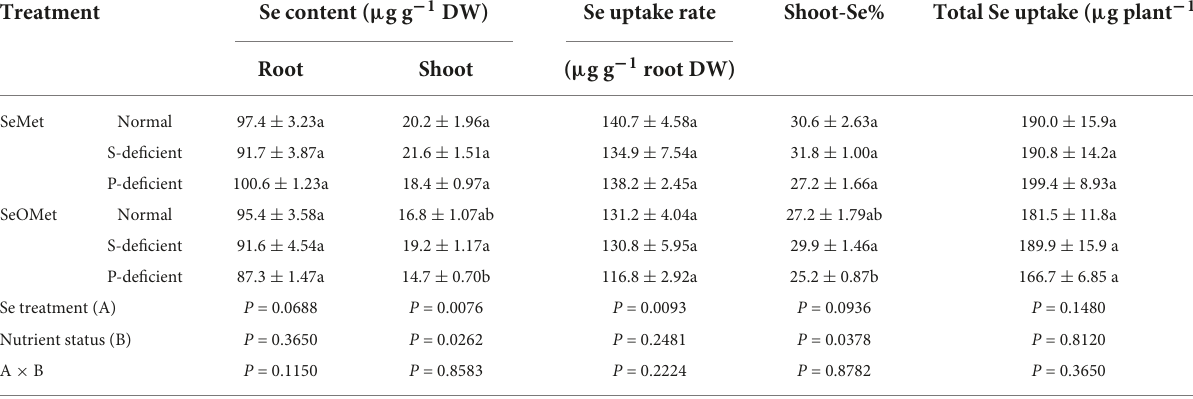
TABLE 2 Effect of Se chemical forms supplied and nutrient status on the content, uptake rate, and proportion of Se allocated to rice shoot. Treatment